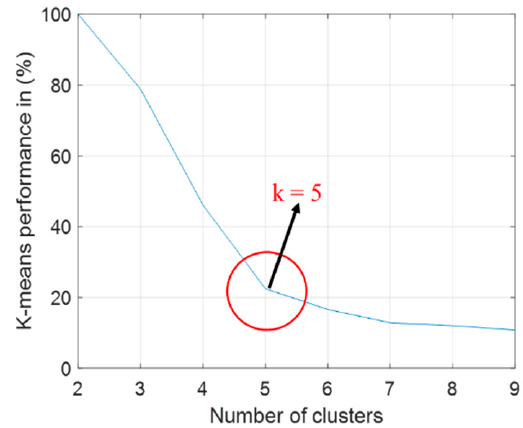
Figure 6. Performance curve in elbow method for selecting the ideal number of groups in the dataset.